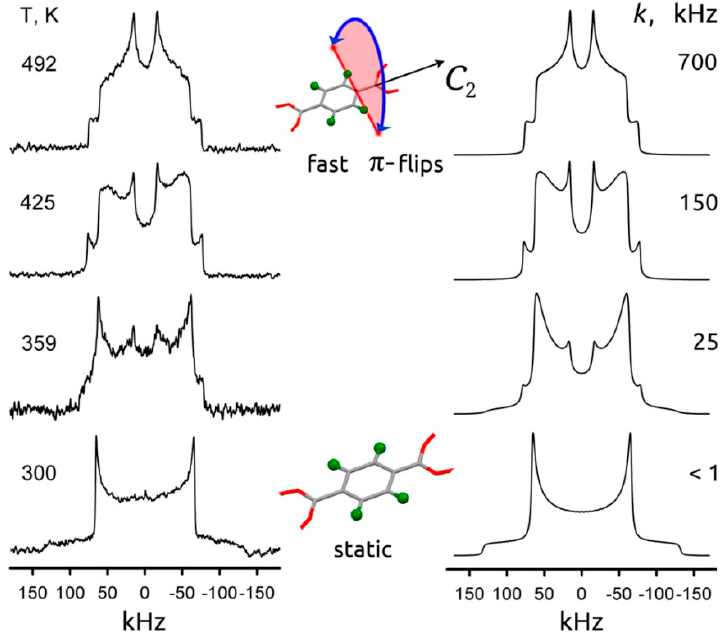
Figure 15. Experimental ( left column) and simulated ( right column) 2 H NMR line shapes of the p -phenylene rotor in MIL-53(Al) at different temperatures. Reproduced with permission from [19]. Copyright American Chemical Society, 2014.